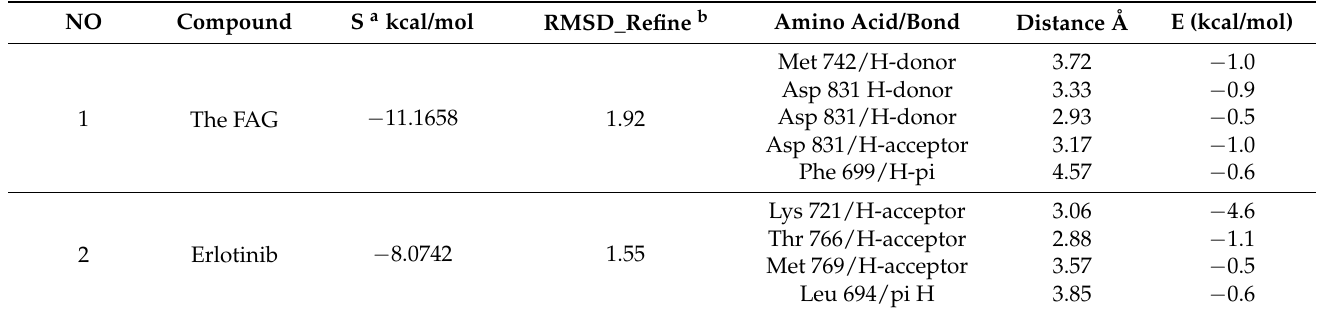
Figure 7. Docking results of the FAG in the active pocket site of EGFR catalytic domain, (1M17). ( A ) 2D interactions of erlotinib, ( B ) 2D interactions of FAG, and ( C ) Docking pose of FAG. The docking results revealed that FAG has a high affinity toward the EGFR catalytic domain as it exhibited binding energy with a score of − 11.165 kcal/mol, which is lower than the dock score of the co-crystalized ligand (erlotinib), − 8.074 kcal/mol. The 2D interactions shown in Table 2 and Figure 7 displayed an HB binding mode with Met 742 and the hydroxyl group of the glucopyranosyl moiety as H-donor. Similarly, the amino acid residue, Asp831, exhibited two HB interactions, H-donor with two sugar moieties and one as an H-acceptor with the hydroxyl group of the glucopyranosyl moiety, in addition to a hydrophobic interaction with Phe 699 as an H-pi interaction. Table 2. Receptor interactions and binding energies of the new FAG and erlotinib into the active pocket site of EGFR catalytic